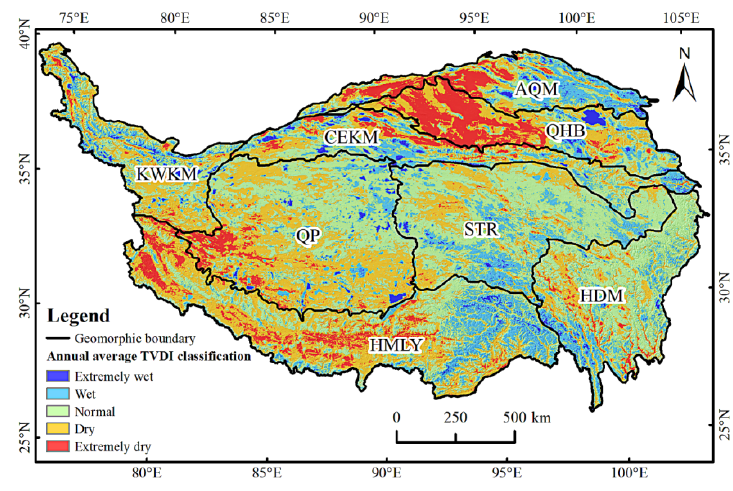
Figure 6. Annual average TVDI classification of the QTP.